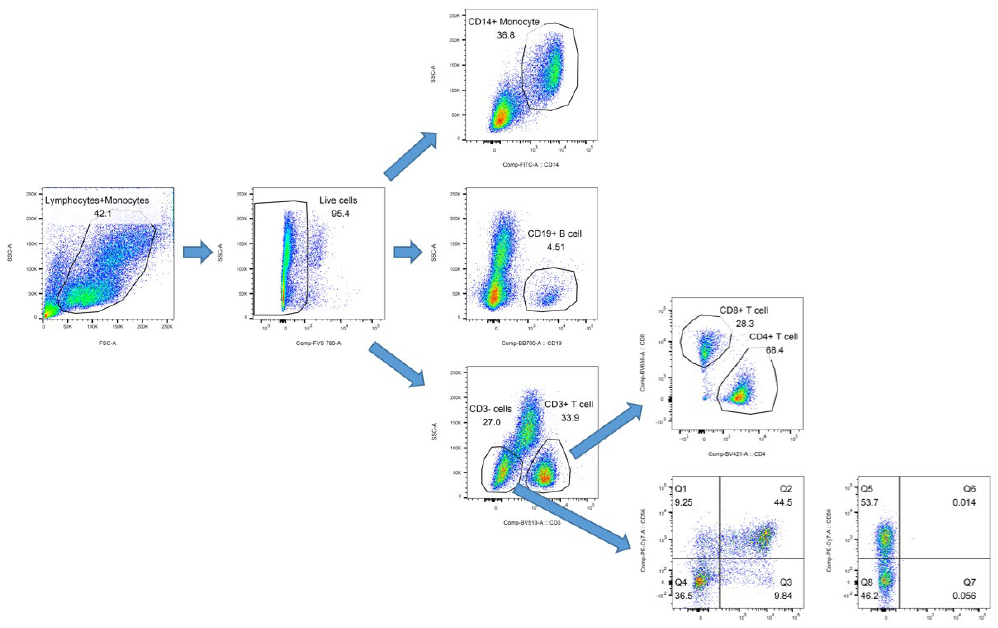
Figure A1. Immune cell analysis protocol (panel 1).